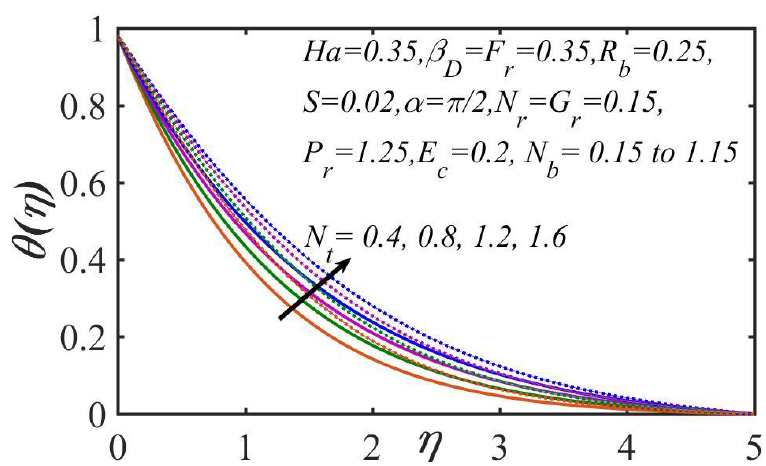
Figure 7. Impact of 𝑁 𝑡 and “ 𝑁 𝑏 ” on temperature magnitudes. Solid curve: 𝑁 𝑏 = 0.15 ; dotted curve: 𝑁 𝑏 = 1.15 .